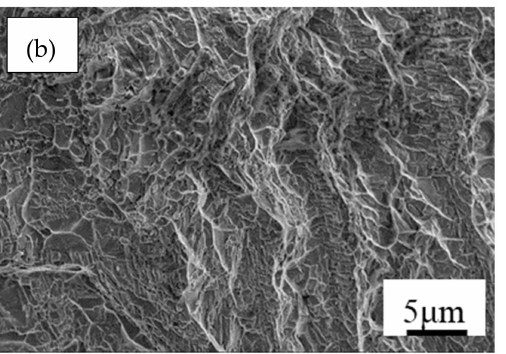
Figure 9. The fracture morphologies after tensile test of Fe–Mn–Cr–CN TWIP steels: ( a ) 12CrN; and ( b ) 18CrN.